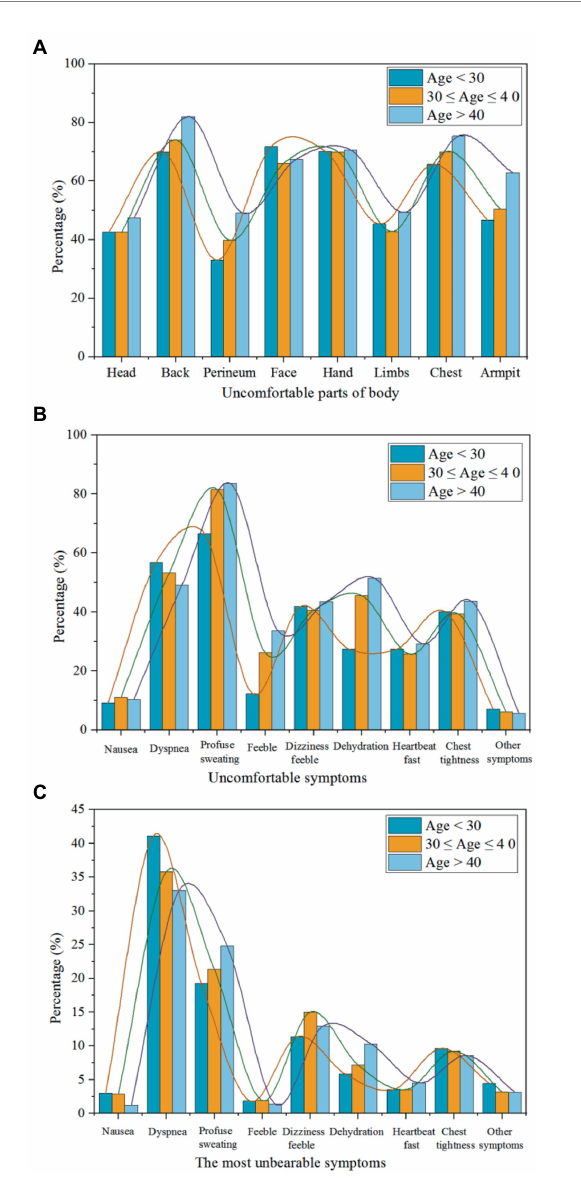
FIGURE 5 Distribution of uncomfortable parts of the body and symptoms (with PPE) under different age